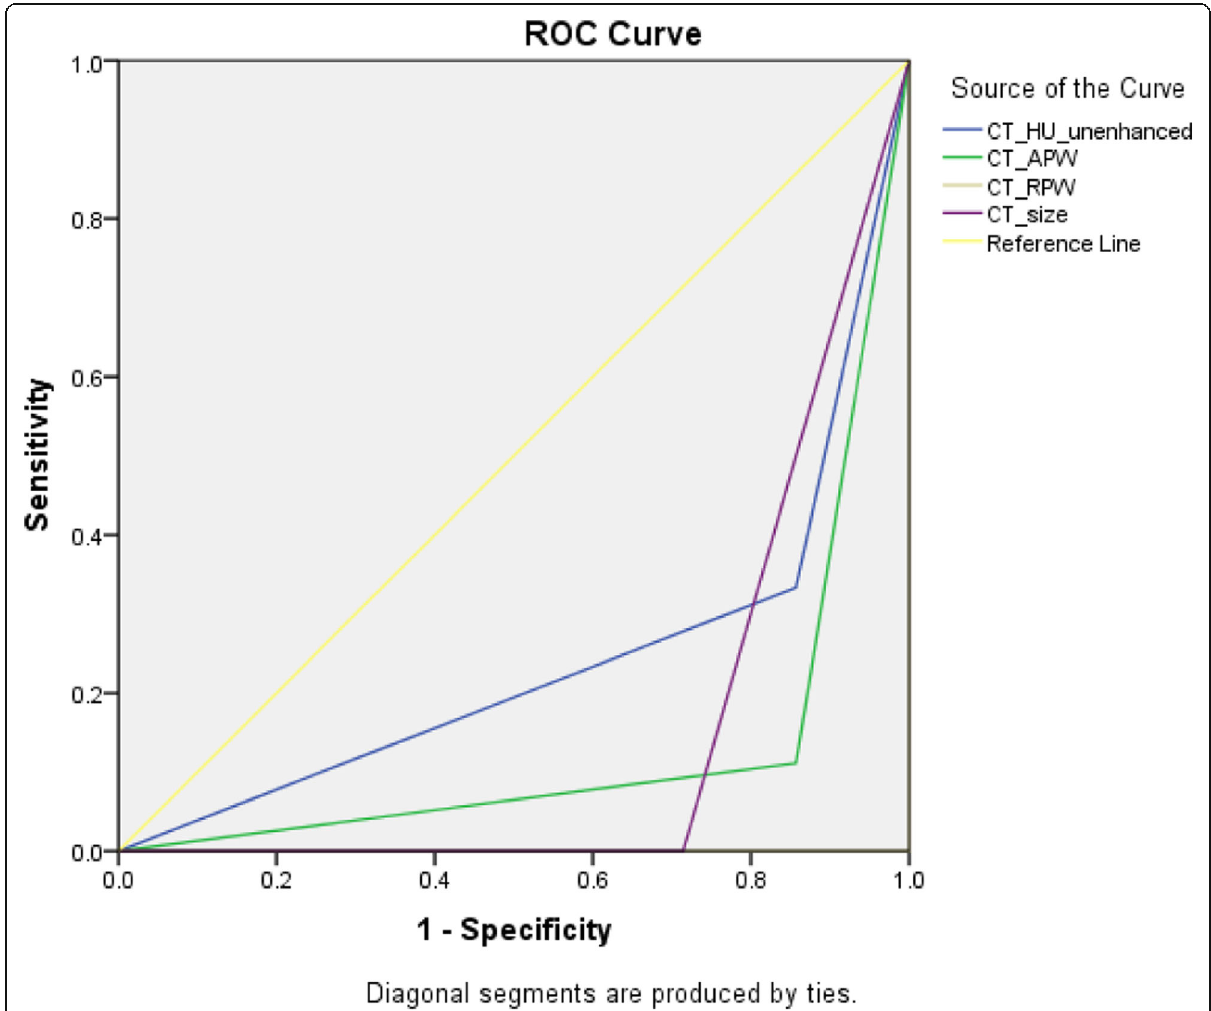
Fig. 2 CT variables diagnostic value/validity in lipid-rich adenomas